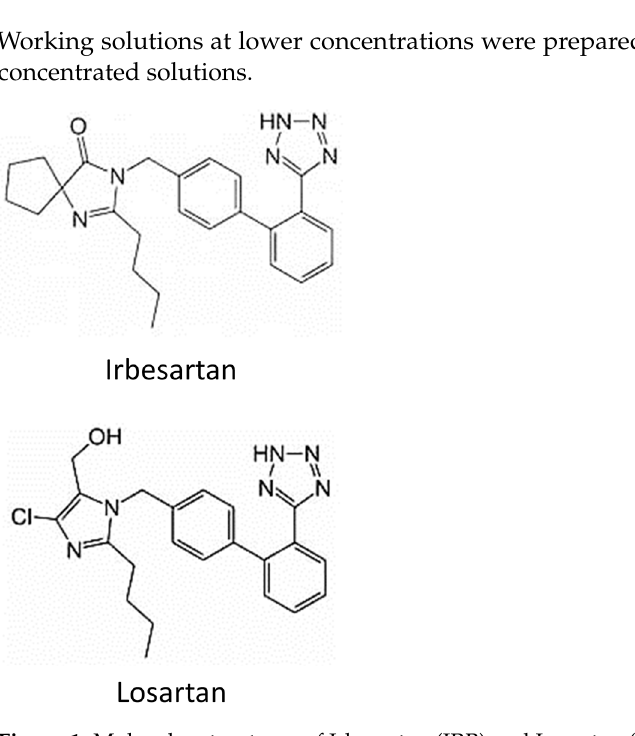
Figure 1. Molecular structures of Irbesartan (IRB) and Losartan (LOS).